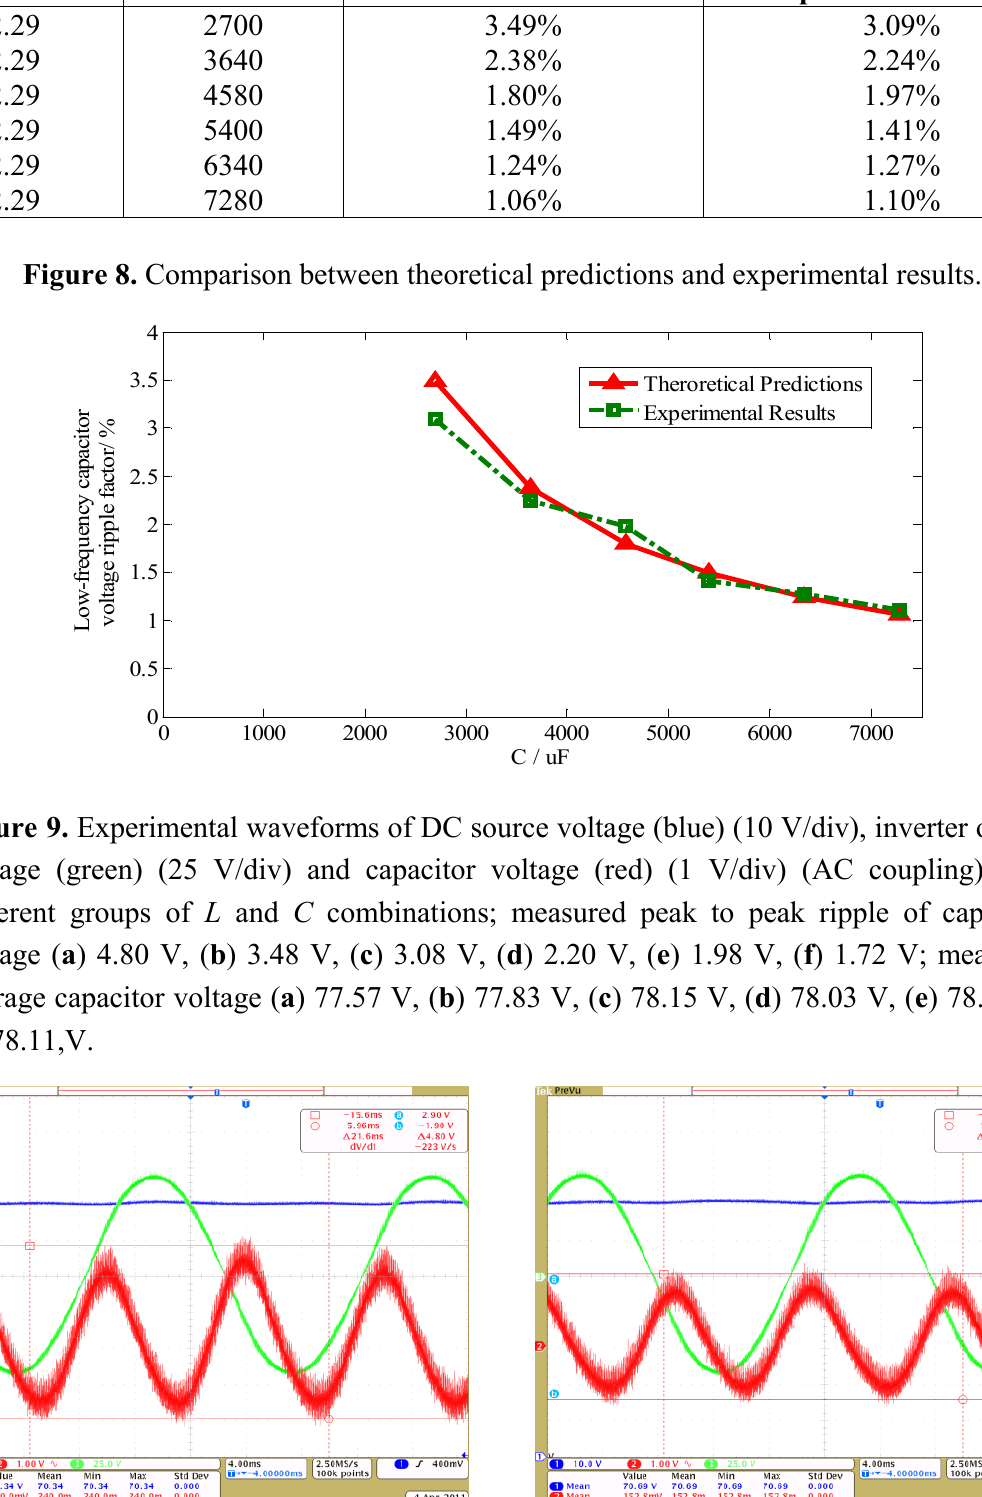
Table 3. Comparison between theoretical predictions and experimental results. Z-Source Network Parameters